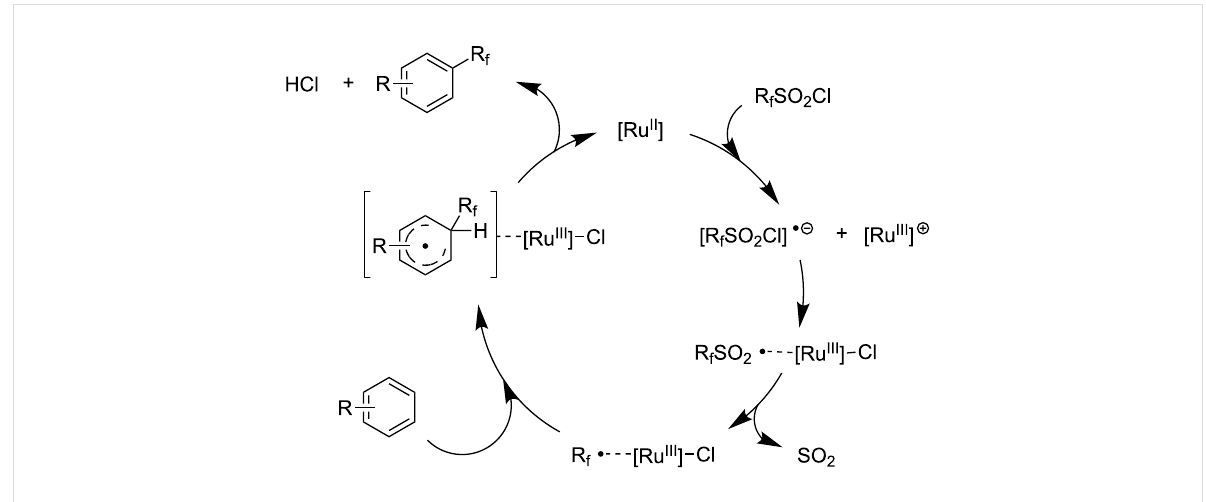
Figure 14: N. Kamigata et al.’s proposed mechanism for the Ru-catalyzed perfluoroalkylation of alkenes and (hetero)arenes with perfluoroalkylsul- fonyl chlorides [100].